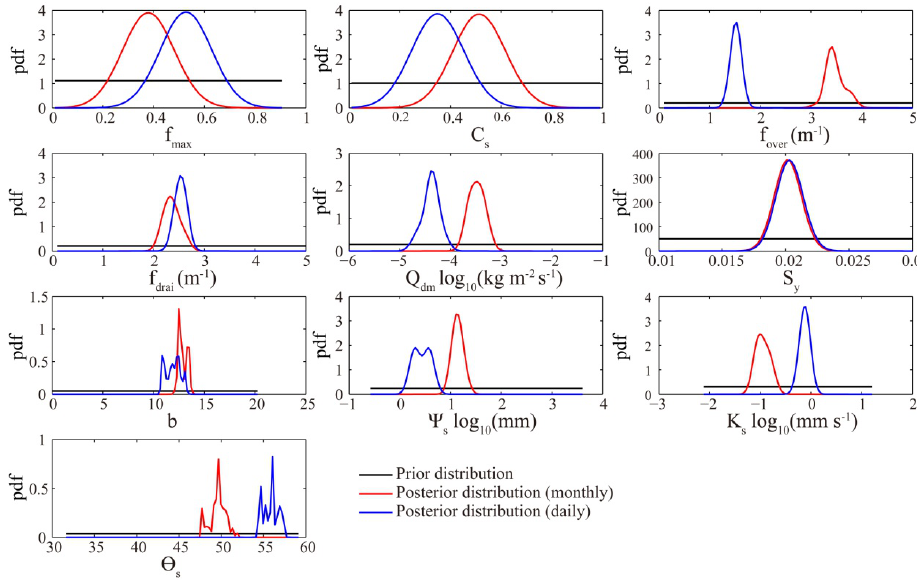
Fig. 13. Posterior distribution of the parameters through Bayesian model averaging at the US-ARM site.